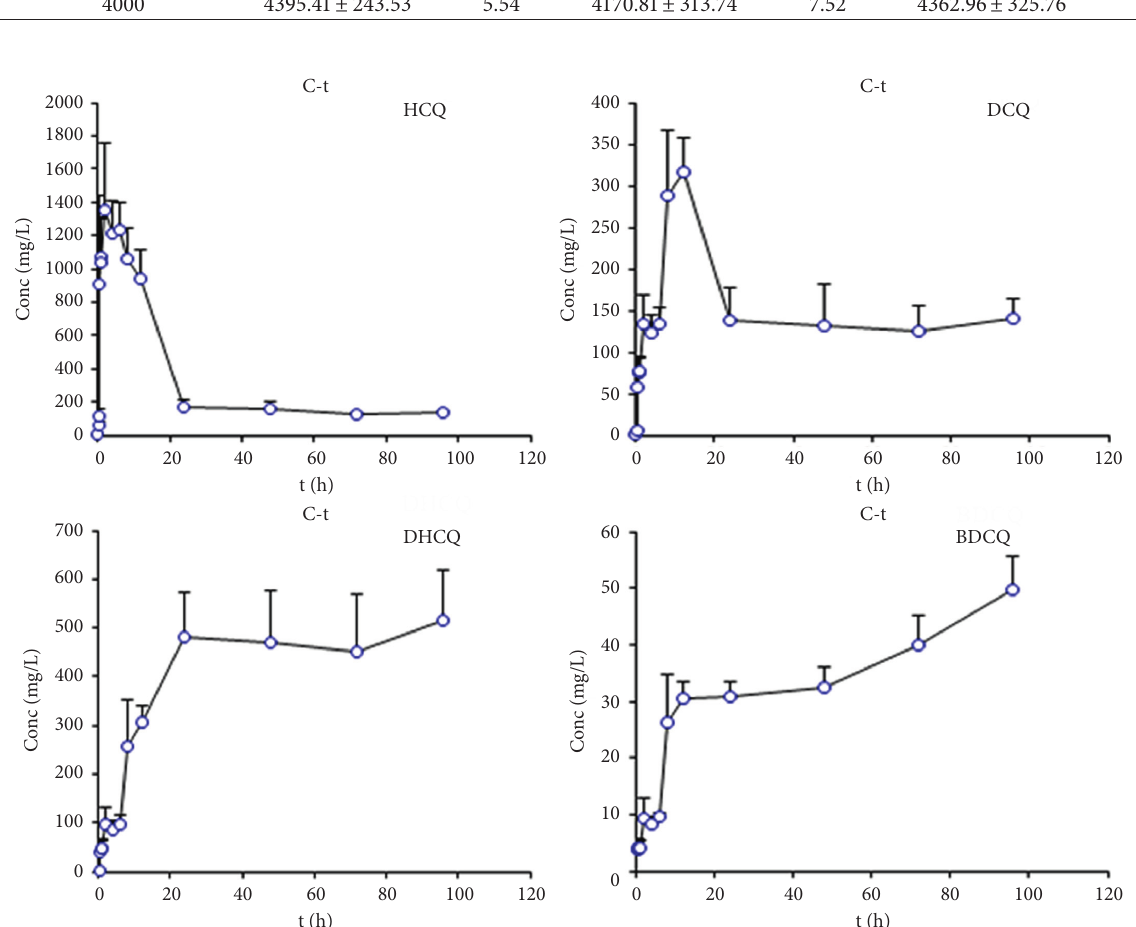
Figure 3: The mean concentration-time(C-t) curves of HCQ and three metabolites in rat blood after intragastric administration. Table 6: Blood pharmacokinetic parameters of HCQ and its three metabolites in rat ( n �